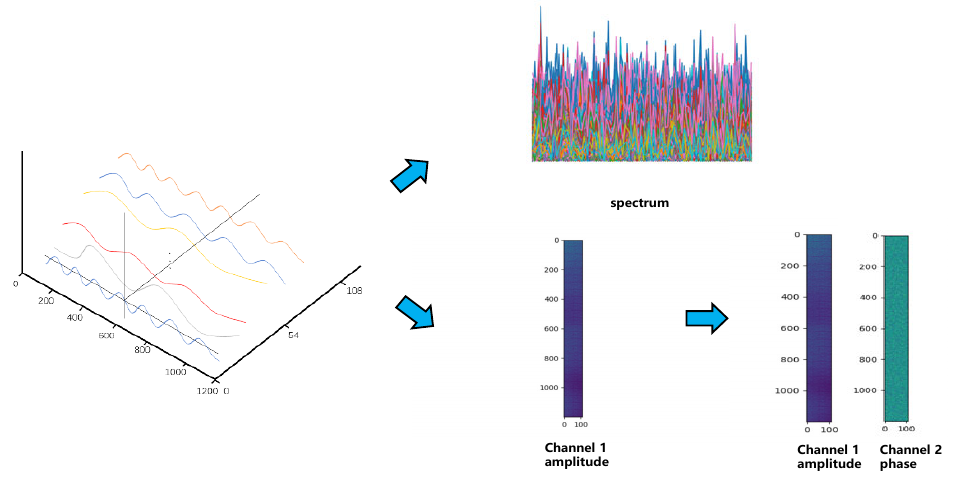
Figure 4. Data preparing. We tried plenty of data types, including spectrum, one-channel (amplitude), and two-channels (amplitude and phase).